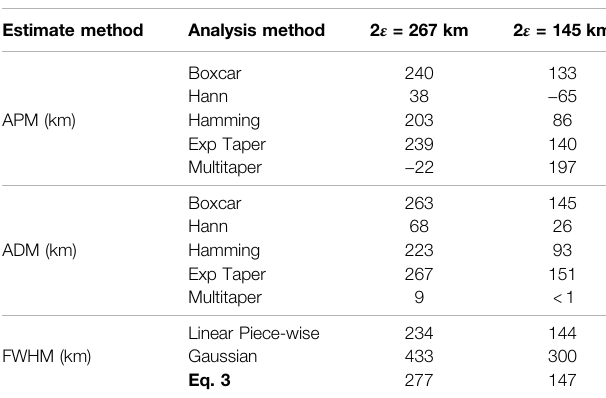
TABLE 4 | APM, ADM, and FWHM estimates of the latitudinal resonance width in km, with uncertainty, for the driven damped harmonic oscillator model. 2 ε = 267 km corresponds to the γ / ω 0 = 0.1 case, and 2 ε = 145 km corresponds to the γ / ω 0 = 0.055